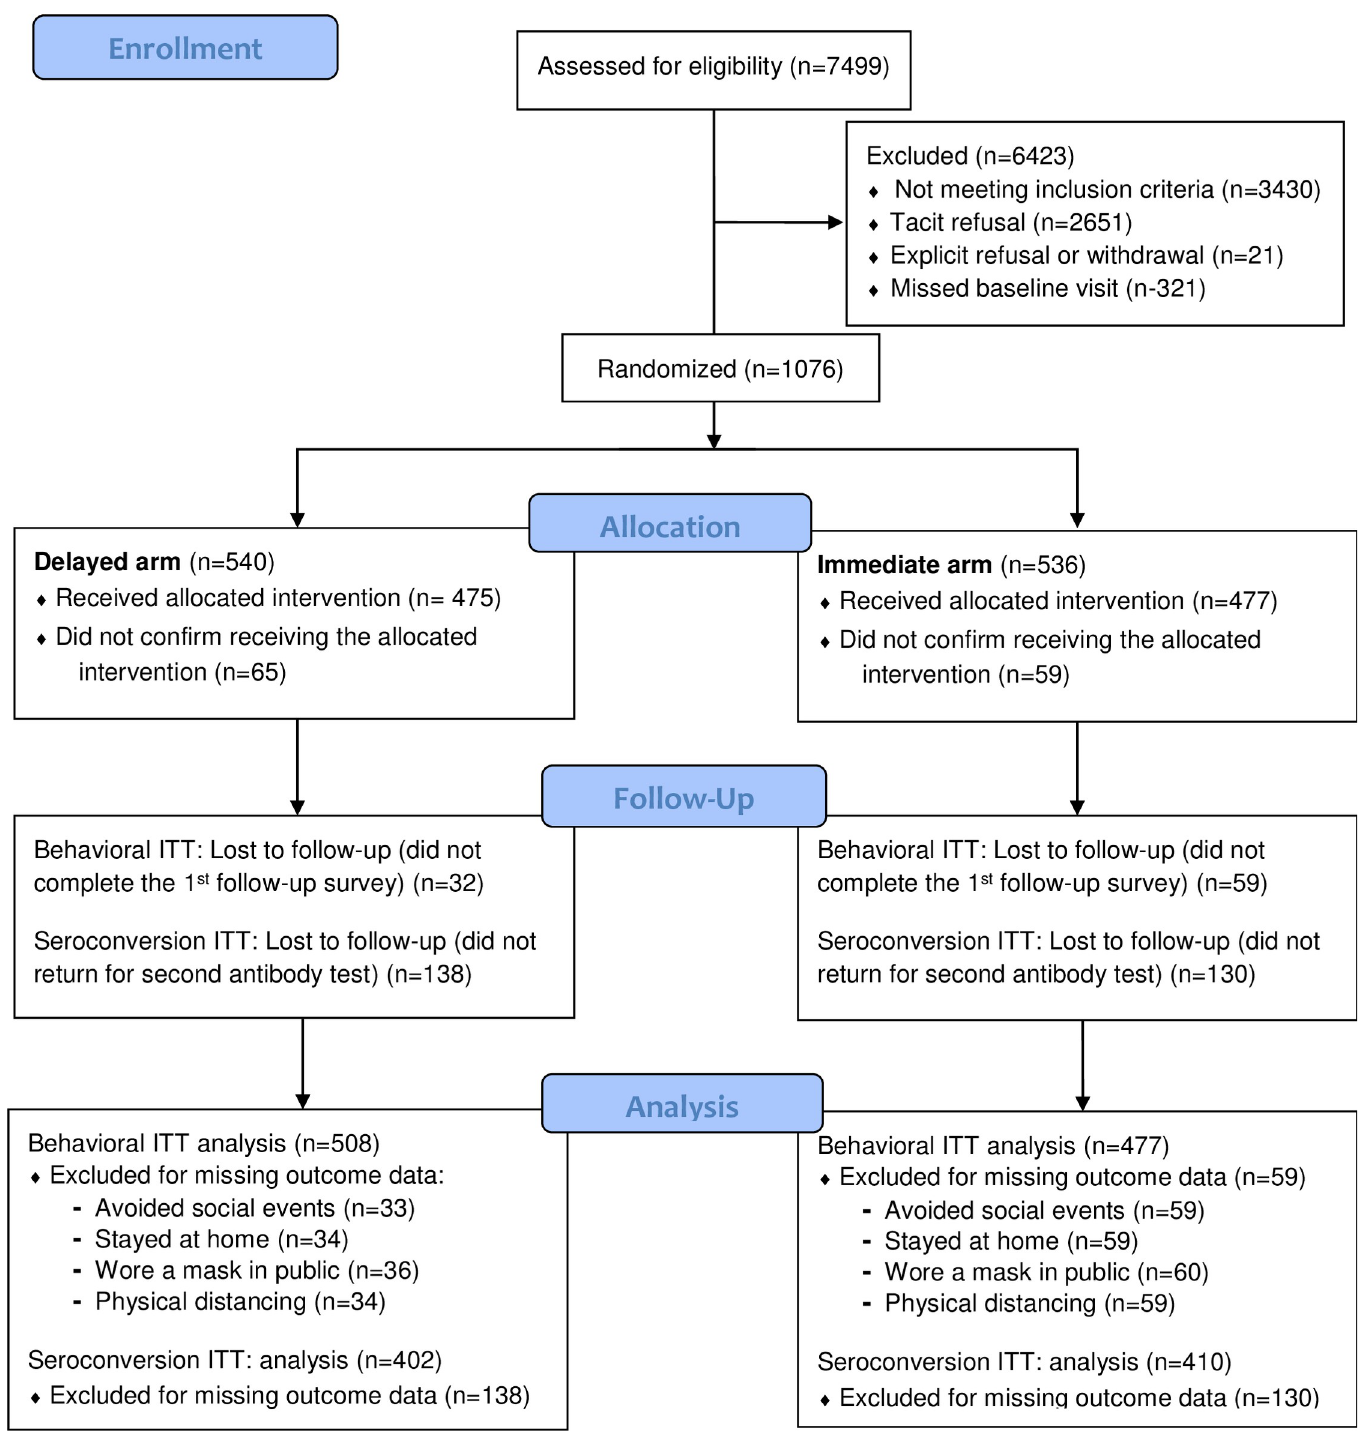
who were seronegative at baseline. Participants in the immediate condition did not exhibit a higher or lower risk of seroconversion at 8 weeks, compared to the delayed condition [RR